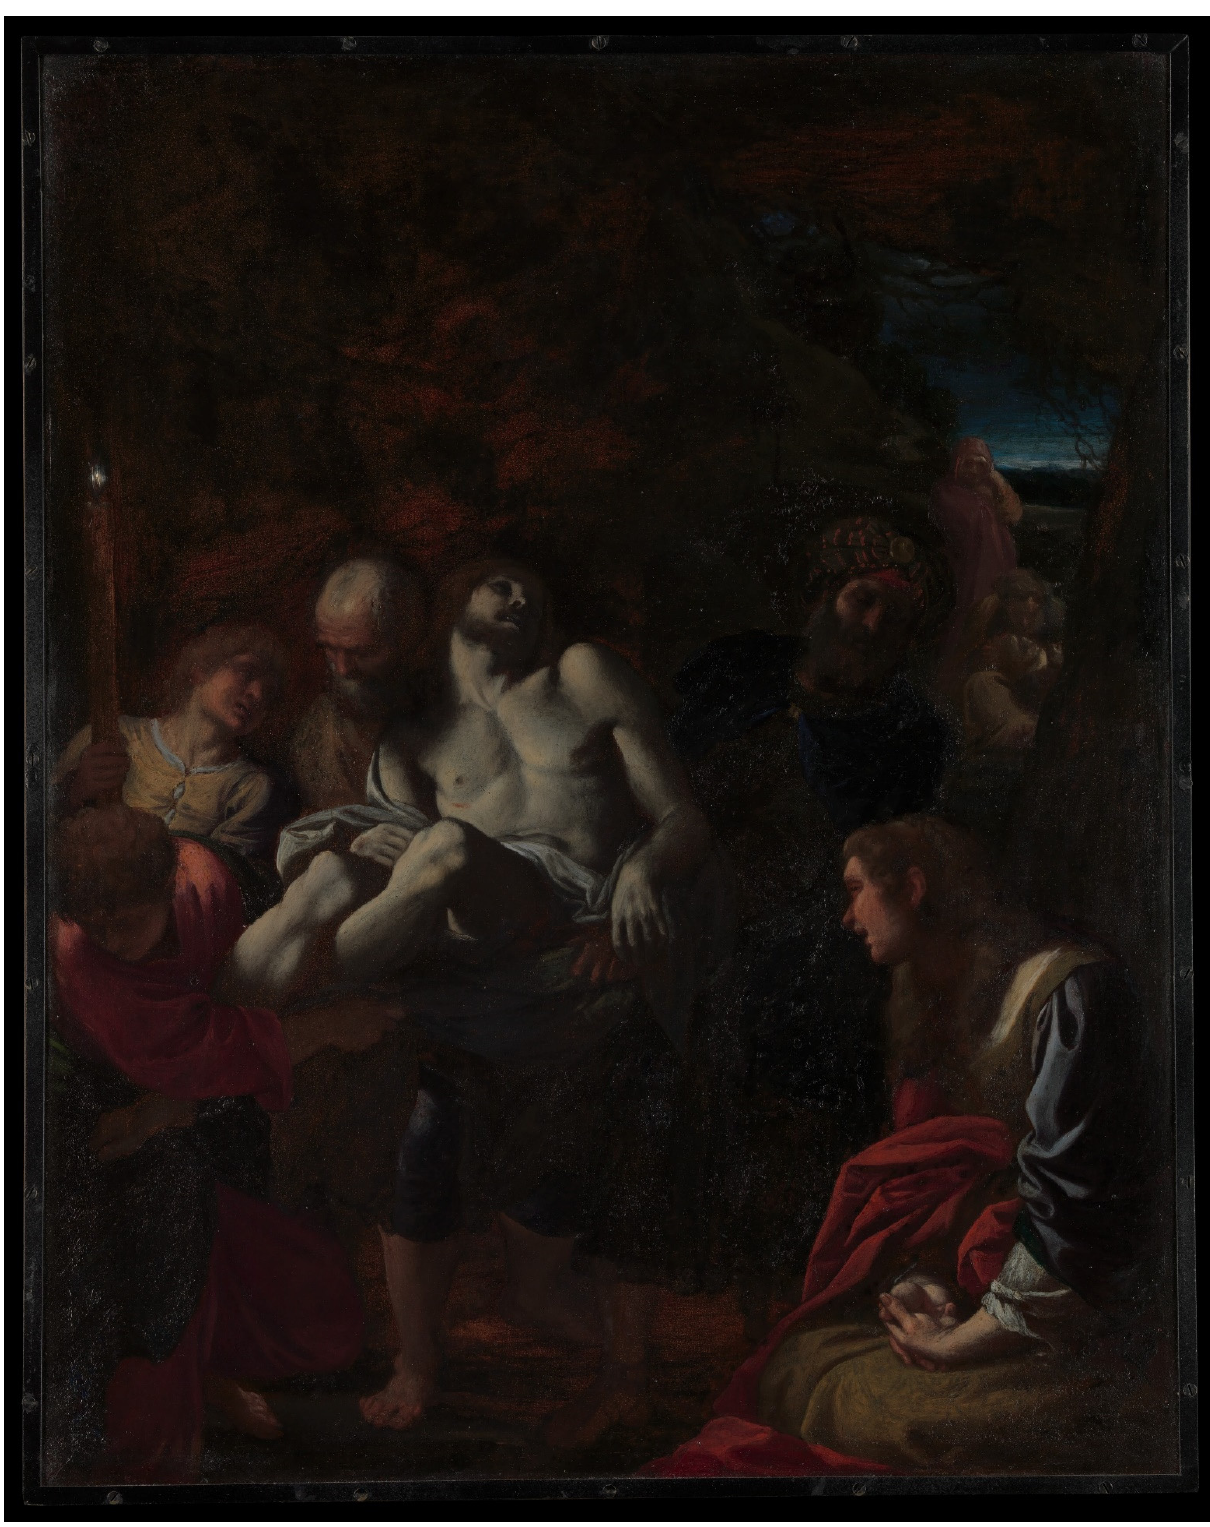
Figure 9. Annibale Carracci, The Burial of Christ , 1595. Oil on Copper. The Metropolitan Museum of Art, New York, U.S. Image Courtesy of the Metropolitan Museum of Art, New York, U.S. Edwin L. Weisl Jr. Gift, 1998; https://www.metmuseum.org (accessed on 20 June 2021).